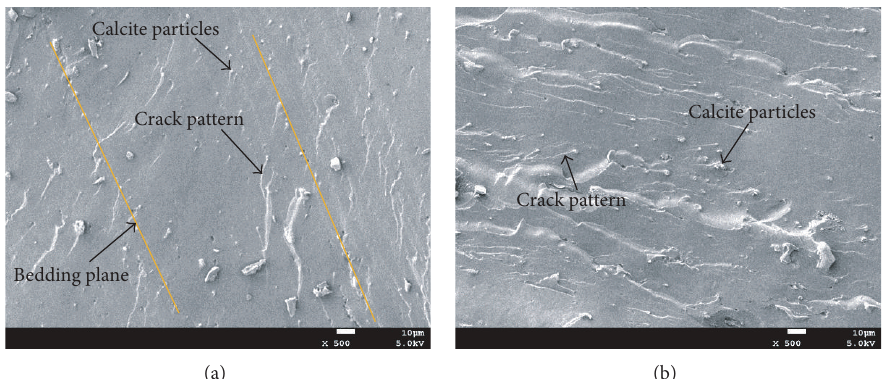
Figure 2: SEM images of the failure surface ( × 500): (a) the failure surface which is vertical to the bedding planes, (b) the failure surface which is parallel to the bedding planes.